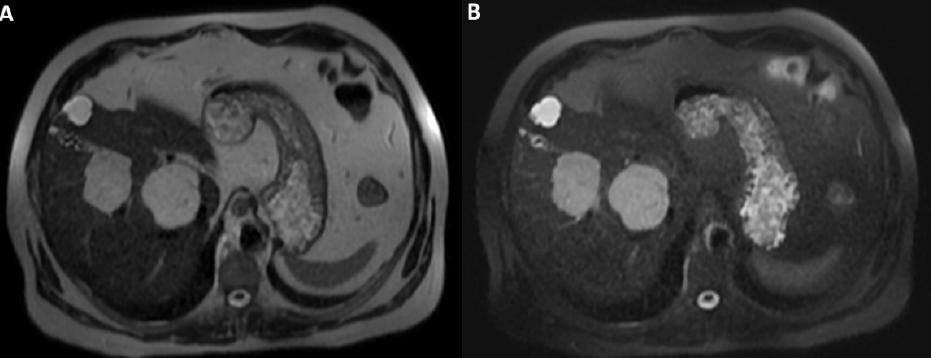
Figure 2. On T2WI without fat-suppression ( A ) and with fat-suppression ( B ) acquired a few days later without previous contrast agent administration; the lesions’ hyperintensity was clearly homogeneous.